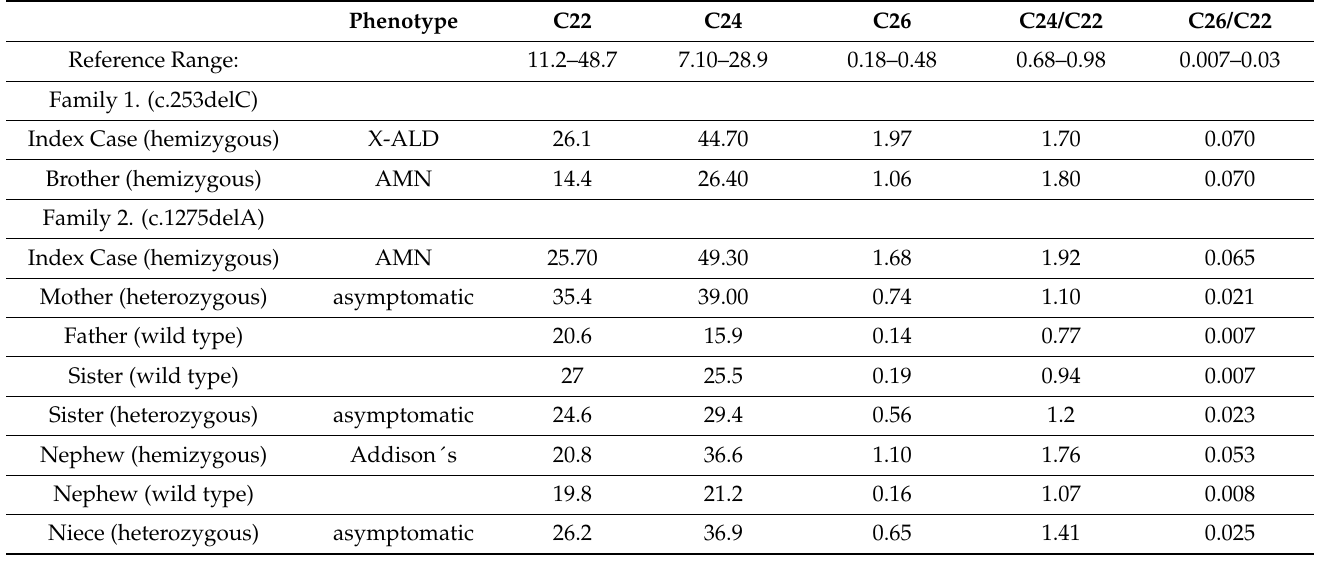
Table 1. VLCFA measurements in the index patients and family members carrying either a variant